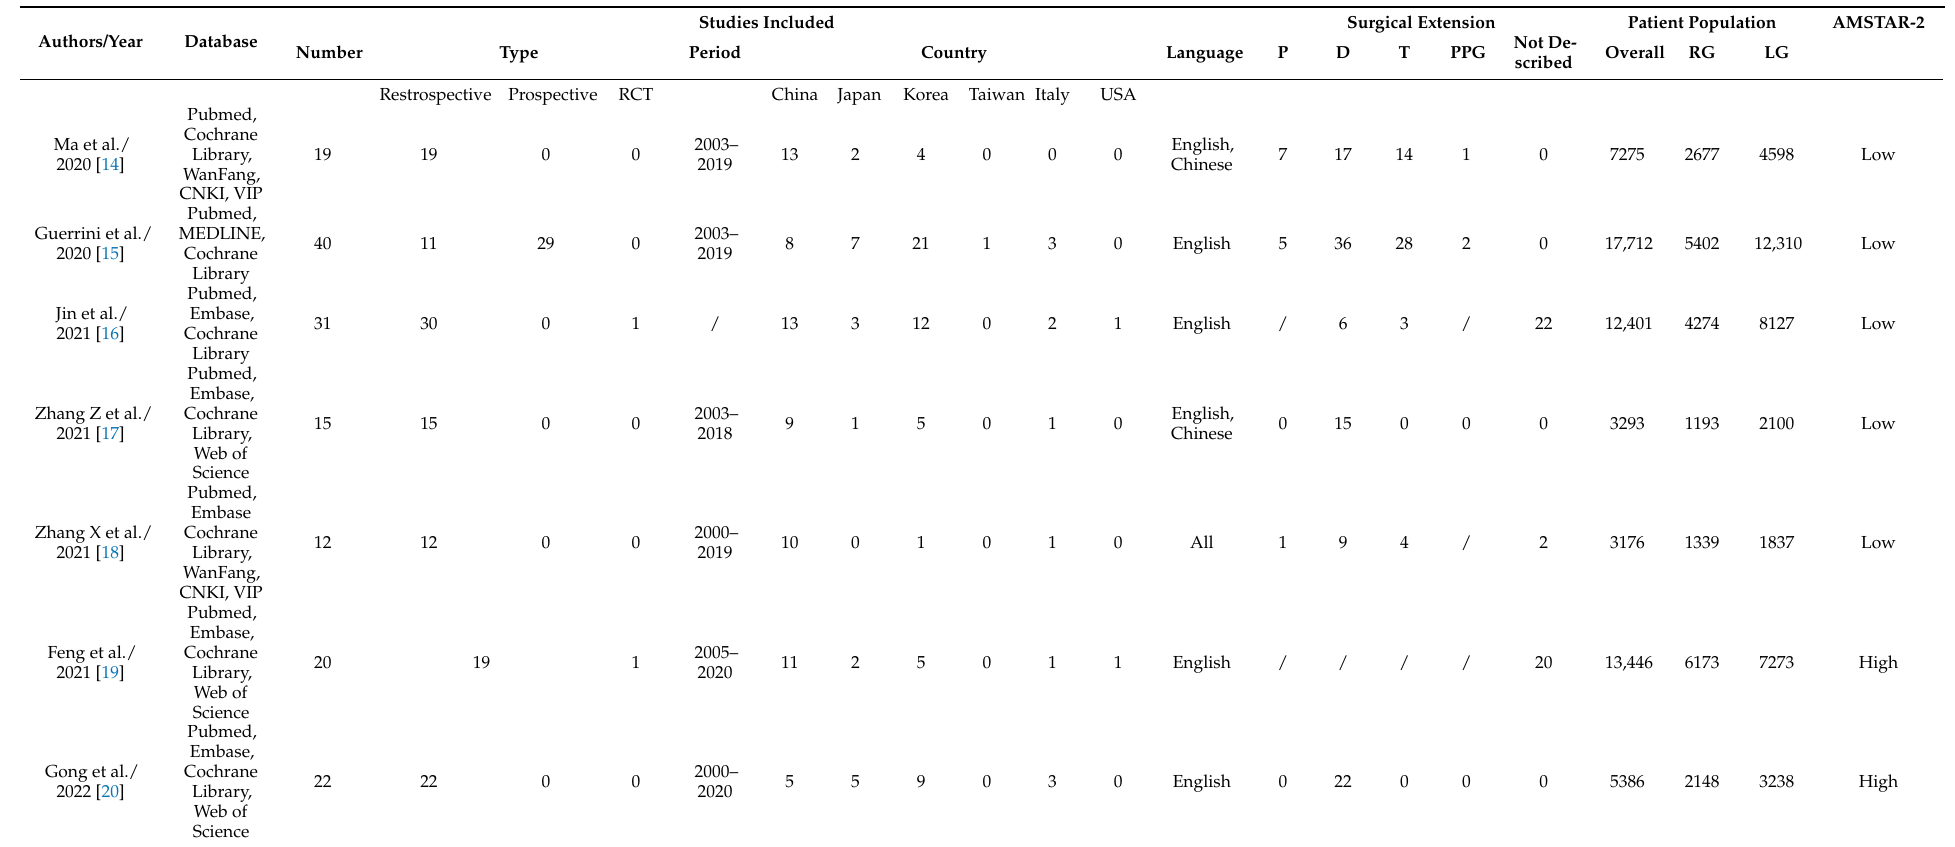
Table 1. General population